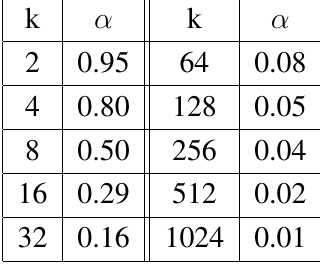
Table 1. Relationship between the moving average window size k and smooth factor α . k